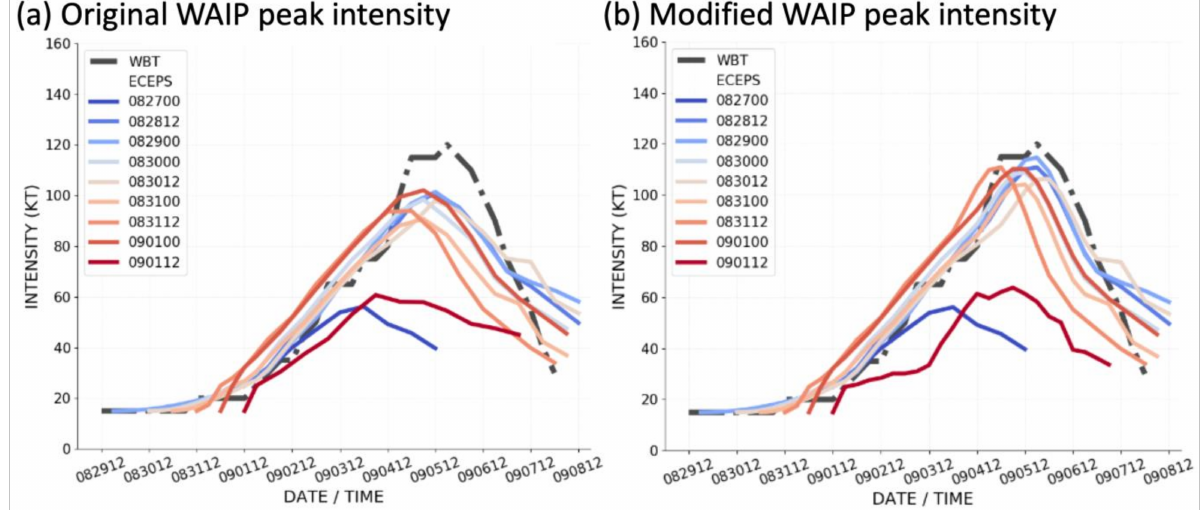
Figure A1. Pre-Lingling circulation WAIP intensity (kt) forecast verifications for the ECEPS T2F (25 kt) as in ( a ) Original combined WAIP of Tsai and Elsberry [4] and ( b ) as modified in this study to improve peak intensity magnitude and timing. Note that panel ( b ) is a repeat of Figure